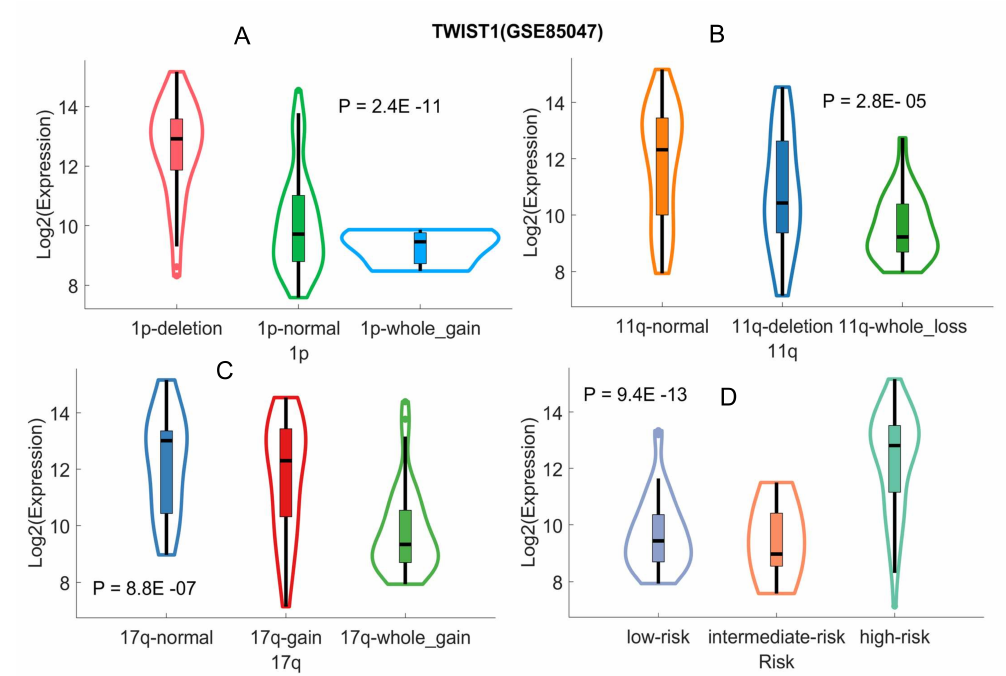
Figure 5. The associations of TWIST1 with genetic alterations and risk status. The p -values were estimated with the one-way ANOVA. ( A ) TWIST1 and 1p deletion. ( B ) TWIST1 and 11q deletion. ( C ) TWIST1 and 17q gain. ( D ) TWIST and risk